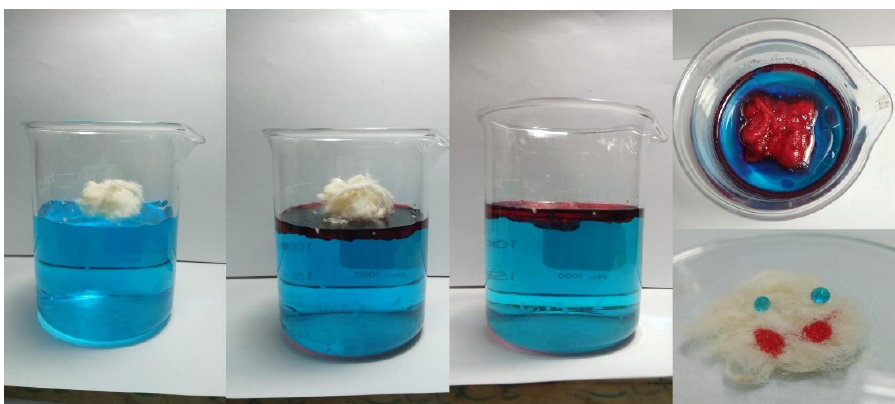
Figure 2. (Color online) Surface wettability test of CaSt 2 -KF on water (dyed with methyl blue) and palm oil (dyed with oil red).